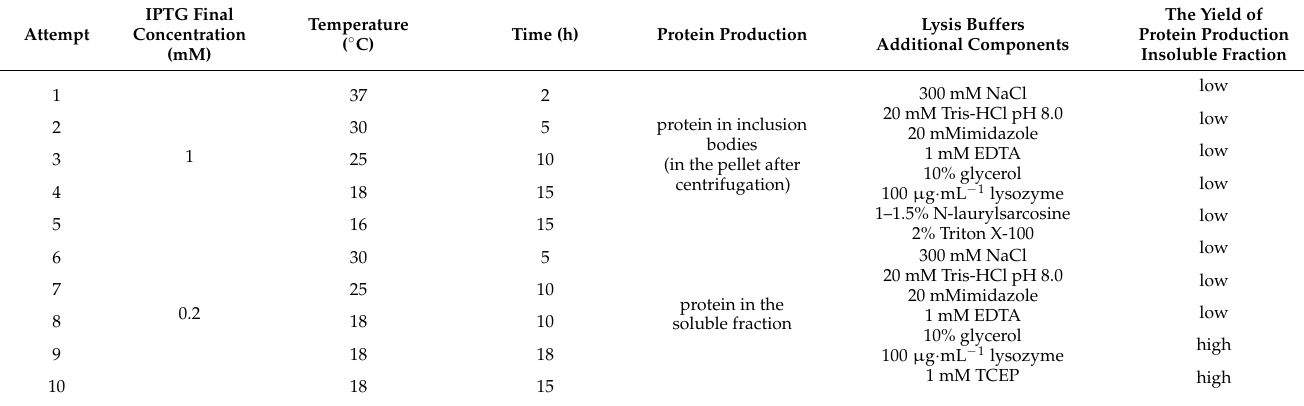
Table 2. Expression and purification conditions were